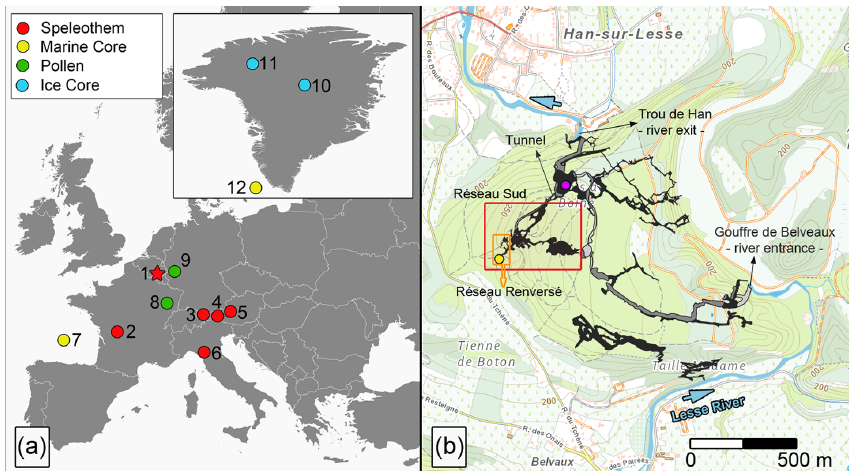
Figure 1. (a) Location of the Han-sur-Lesse Cave site (red star) and other records mentioned in this study: (1) Han-sur-Lesse; (2) Bourgeois- Delaunay Cave (Couchoud et al., 2009); (3) Hölloch Cave (Moseley et al., 2015); (4) Spannagel Cave (Hölzkamper et al., 2004); (5) Entrische Kirche Cave (Meyer et al., 2008); (6) Corchia Cave (Drysdale et al., 2009); (7) MD04-2548 (Sanchez-Goñi et al., 2012); (8) La Grande Pile (Woillard, 1978); (9) Eifel Maar (Sirocko et al., 2005); (10) NGRIP (NGRIP Members, 2004); (11) NEEM (NEEM community, 2013); and (12) MD03-2664 (Irvali et al., 2012). (b) Topographic map of the study area (source: NGI Belgium). The Han-sur-Lesse Cave system is plotted in black. The sampling site of Han-9 is marked by the yellow dot; the purple dot represents the location of cave monitoring by Van Rampelbergh et al. (2014). The Réseau Sud and the Réseau Renversé are shown by the red and orange box, respectively. For further explanation, see text. Figure adapted from Quinif